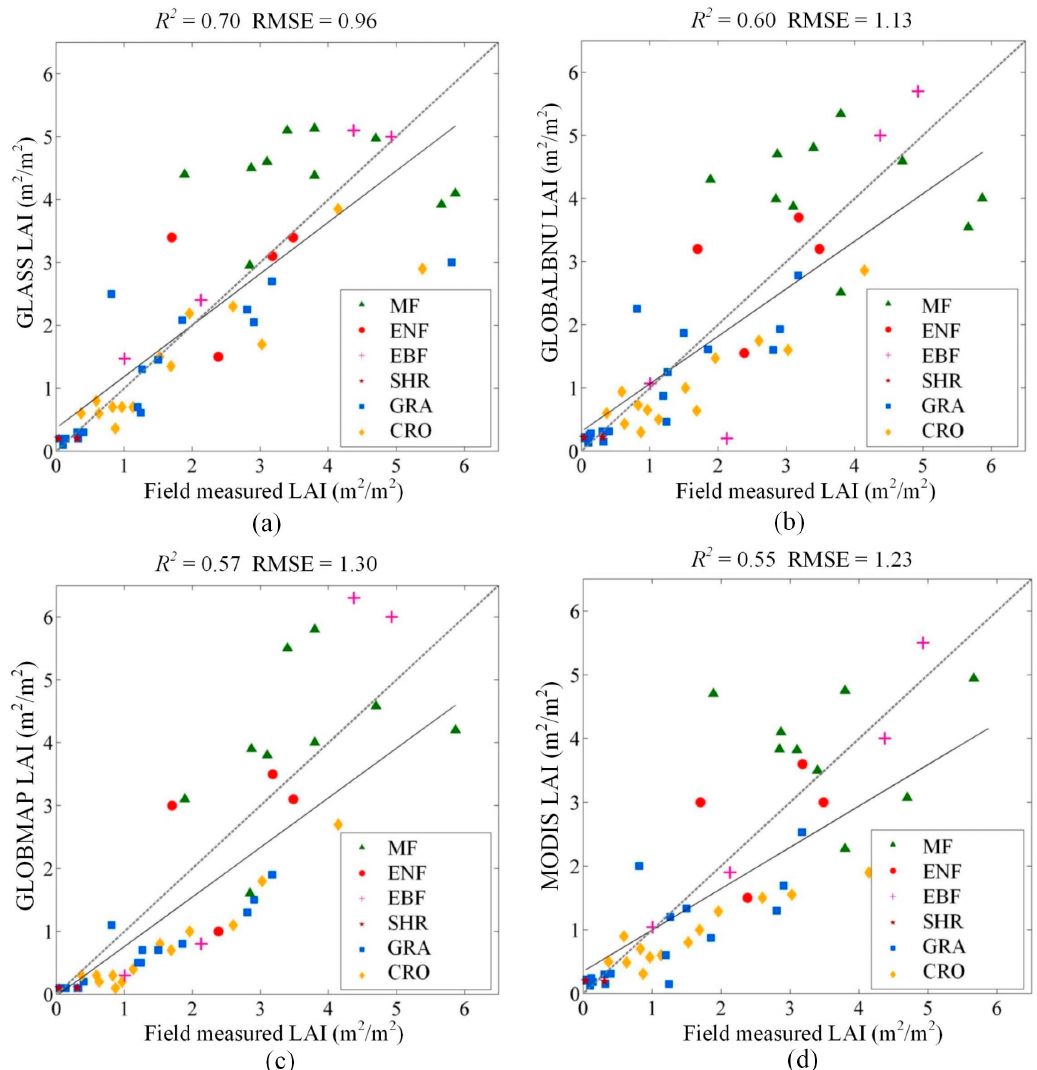
Figure 4. Directly validated scatter plots: ( a ) GLASS; ( b ) GLOBALBNU; ( c ) GLOBMAP; ( d ) MODIS. MF represents mixed forest, ENF represents evergreen needleleaf forest, EBF represents evergreen broadleaf forest, SHR represents shrubland, GRA represents grassland, CRO represents cropland.